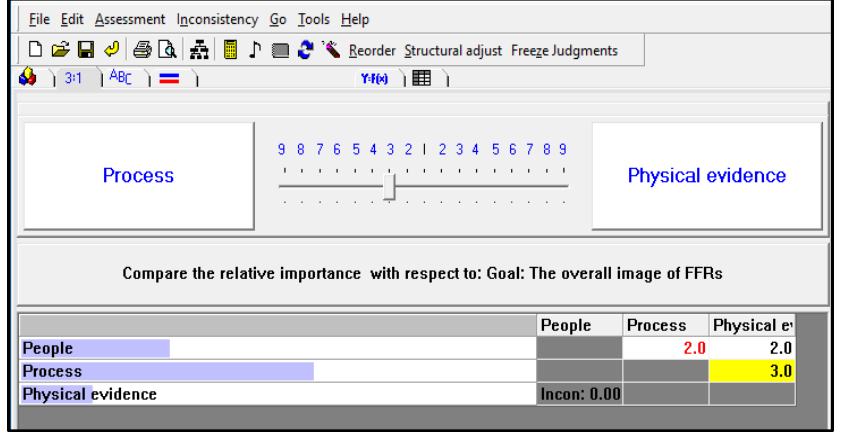
Figure 4. A screenshot of pairwise comparison section of Expert Choice.